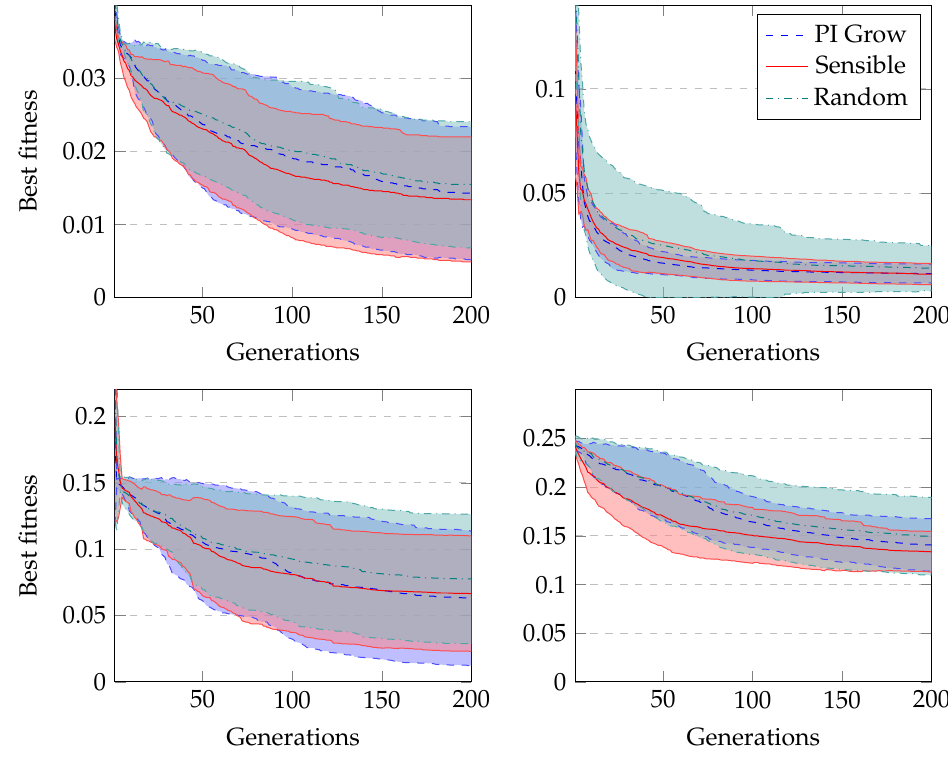
Figure 6. Average fitness of the best individual across generations using GRAPE with different initialisation methods: Vladislavleva-4 ( top left ), Pagie-1 ( top right ), Banknote ( bottom left ) and Heart Disease ( bottom right